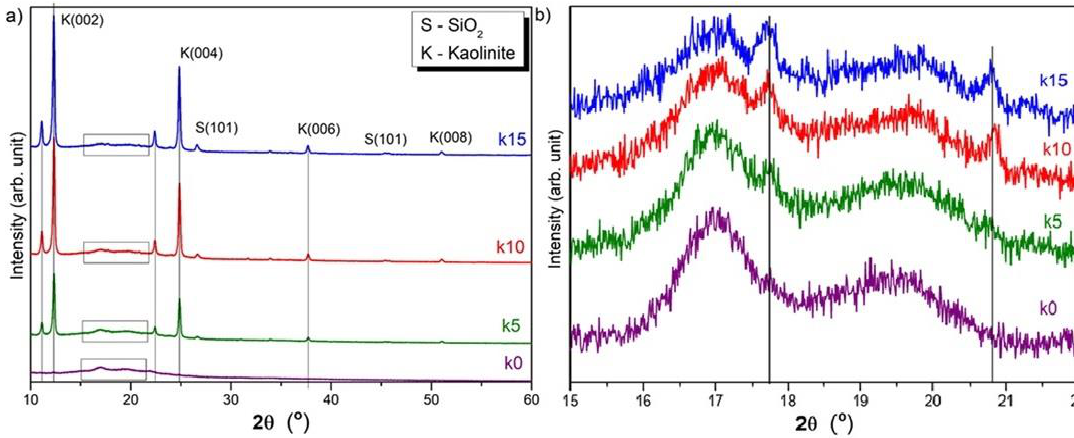
Figure 2. X-ray diffraction patterns of, ( a ) k0, k5, k10, k15 films; ( b ) an enlarged range of diffraction pattern for 2θ from 15° to 22°.